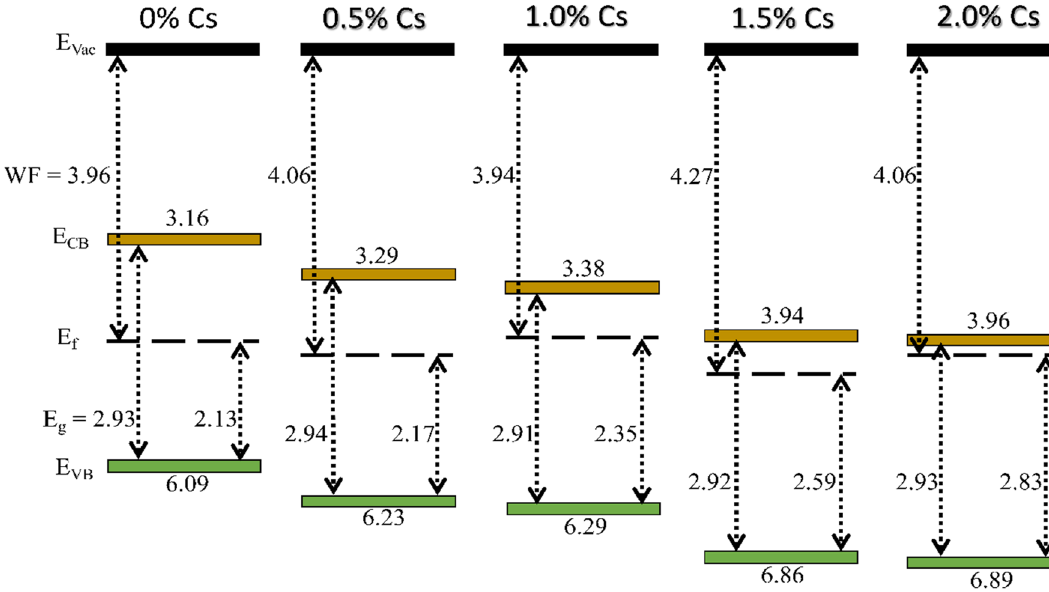
Figure 2. Band diagram of 0.8 M (PEA) 2 (Cs x MA 0.61-x FA 0.39 ) 39 (Pb) 40 (Cl 0.88-0.32x Br 0.12+0.32x ) 121 with 0% Cs, 0.5% Cs, 1.0% Cs, 1.5% Cs, and 2.0% Cs.